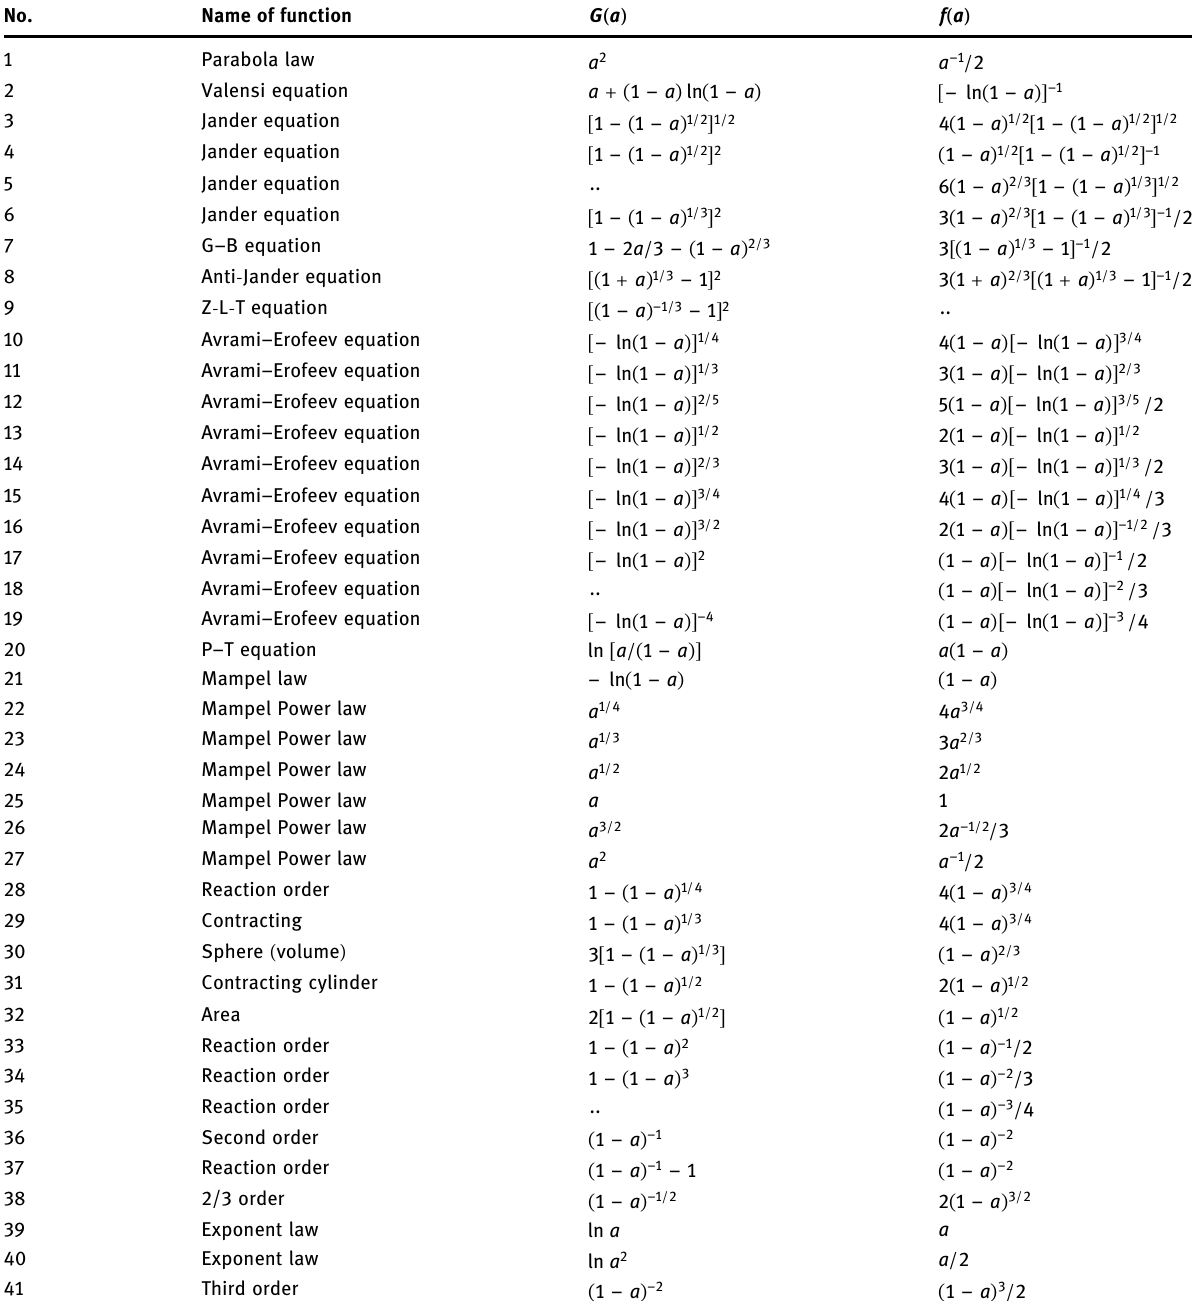
Table A1: Forty - one kinetic functions used for thermal degradation kinetics analysis